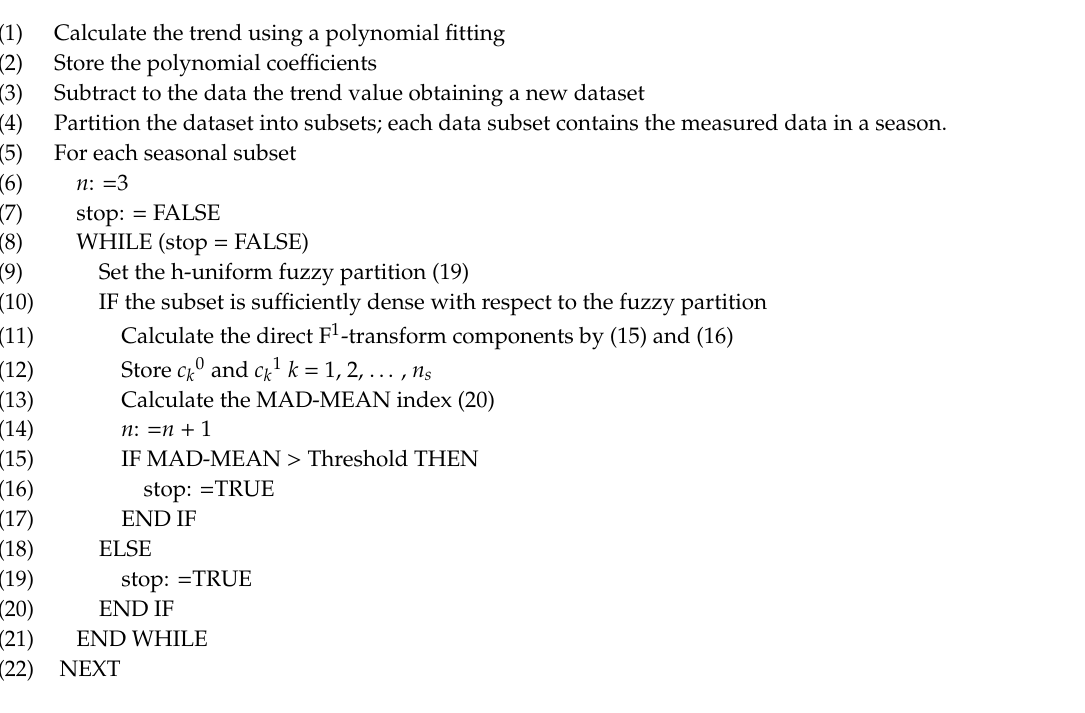
Table 1. Pseudocode of the Time Series Seasonal Forecasting F1 Fuzzy Transform (TSSF1) algorithm.